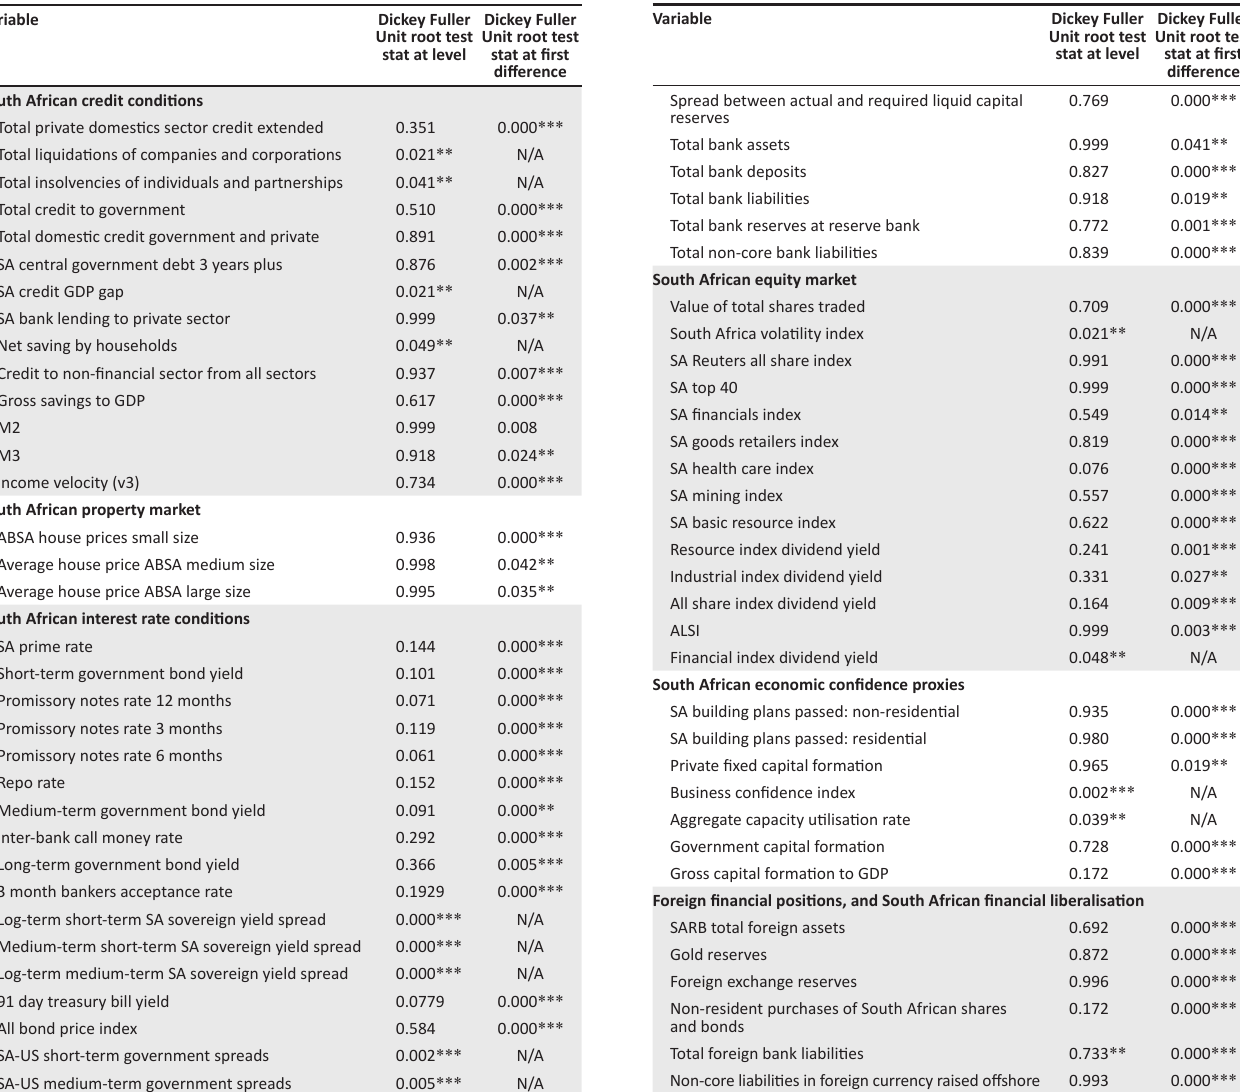
TABLE 1-A1 (continues...): Unit root test results for representing variables in each South African financial